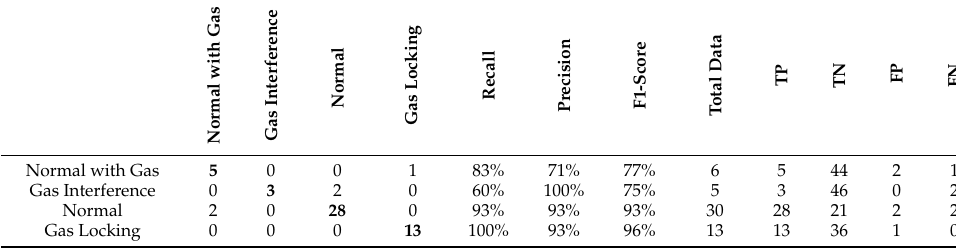
Table 4. Decision Tree parameters with hyperparameters and with unbalanced